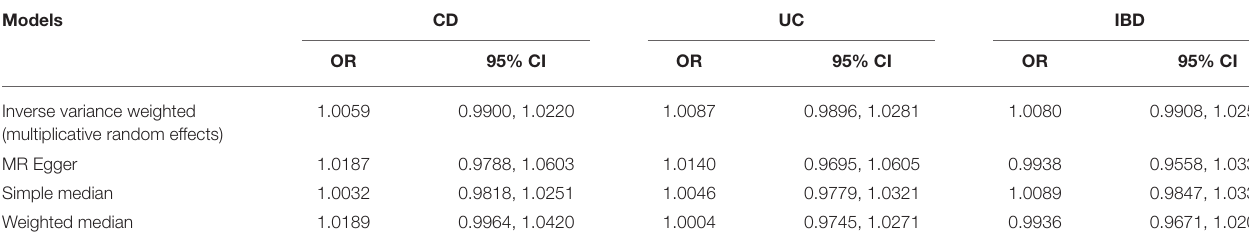
TABLE 2 | MR estimates of the causal effect of CD, UC, and IBD on AF.